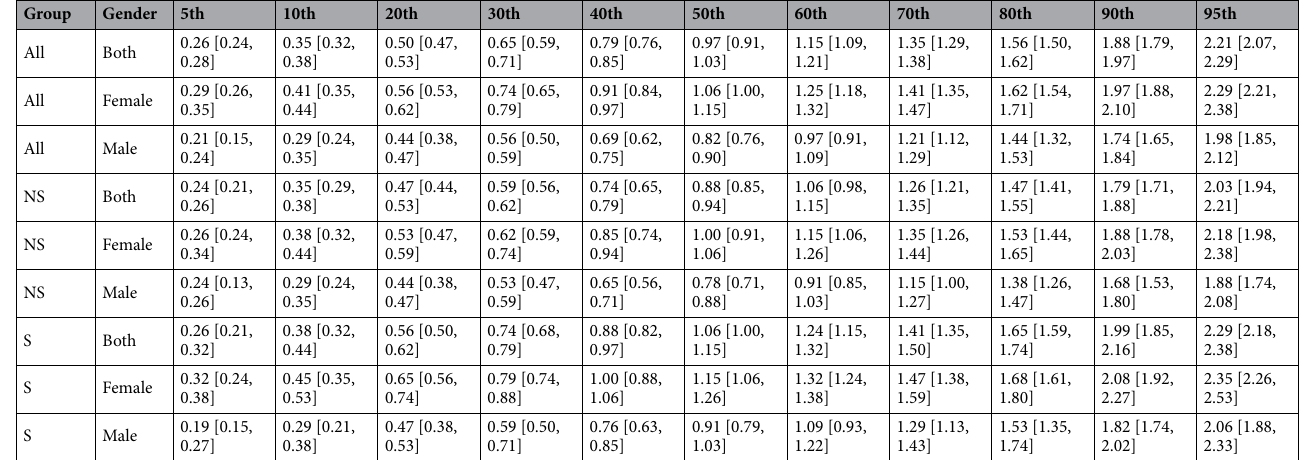
Table 5. Referential centiles for the CORE-OM total score. NS non-student, S student, columns give scores for the centile with 95% confidence